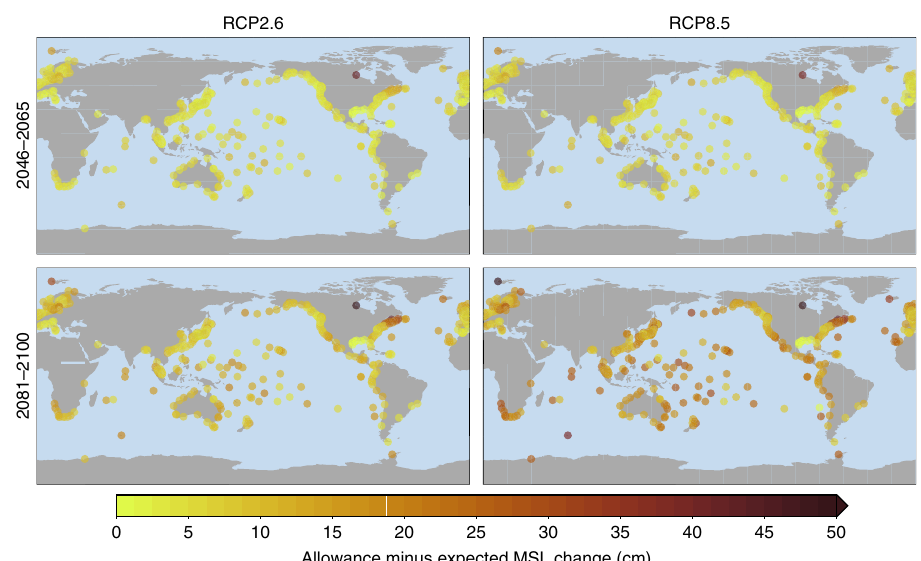
Fig. 6 The 100-year allowance minus the expected mean sea-level change. The allowance minus MSL change only depends on the RCP scenario, since we do not assign an uncertainty to the AIS